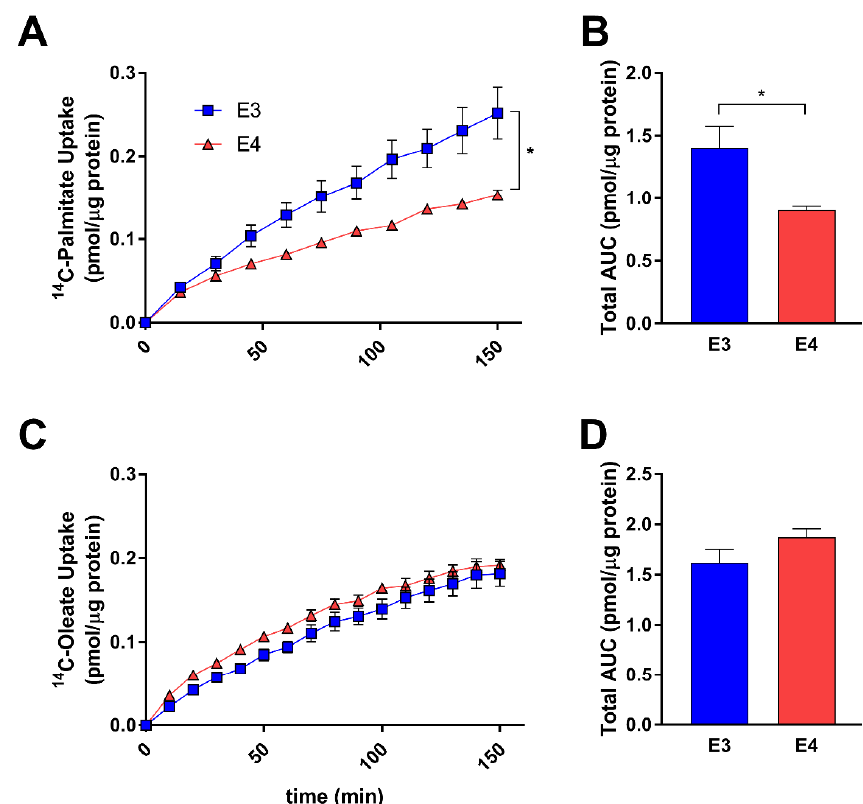
Figure 3. E4 astrocytes uptake less palmitate, but not oleate. E3 and E4 astrocytes were treated with 0.5 µCi/mL [1- 14 C] palmitate ( A , B ) or ( C ) [1- 14 C] oleate ( C , D ) and uptake was measured over 150 min by a scintillation proximity assay. Values represent mean +/ − SEM ( n = 6). Data were analyzed by two-way ANOVA of repeated measures ( A , C ) or t -test ( B , D ); * p < 0.05. Total area under the curve (AUC) was determined for palmitate ( B ) and oleate ( D